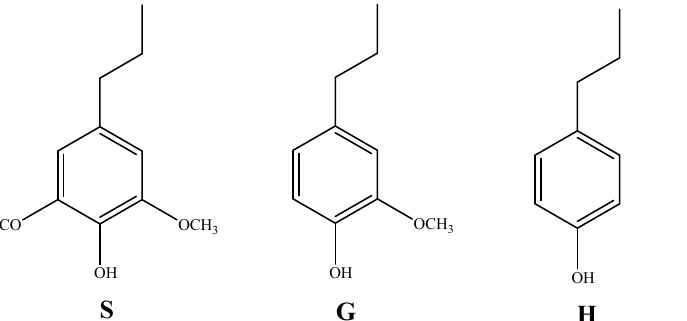
Figure 2. The three monomers of lignin ( p -hydroxyphenyl ( H ), guaiacyl ( G ), and syringyl ( S ); adapted from [15].